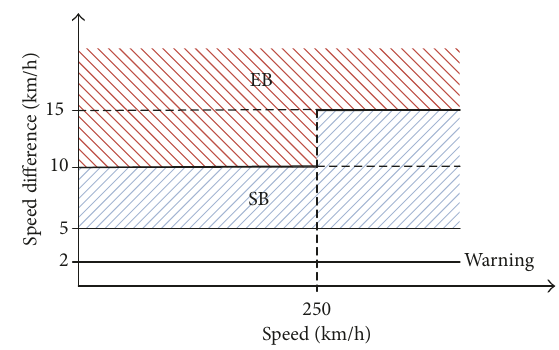
Figure 5: The application ranges of service braking and emergency